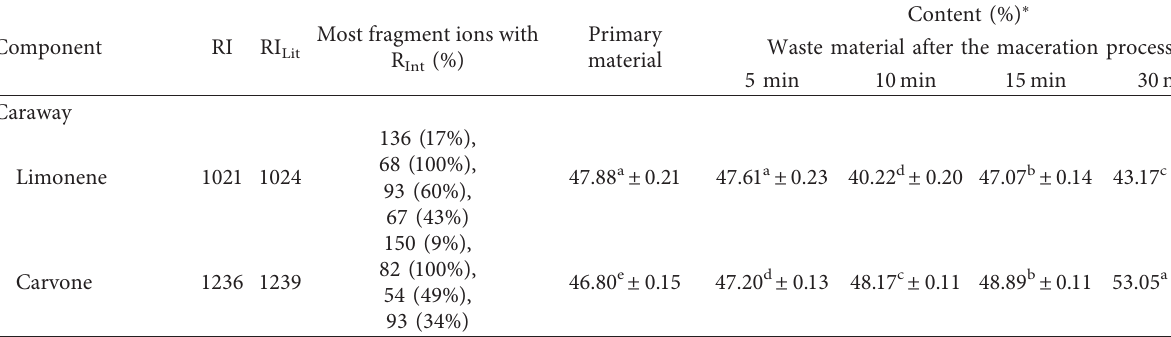
Figure Is: GC-MS chromatogram with dominant compo- nents of sage essential oil. Figure IIs: GC-MS chromatogram with dominant components of lavender essential oil. Figure IIIs: GC-MS chromatogram with dominant components of caraway essential oil. Figure IVs: GC-MS chromatogram with dominant components of chamomile essential oil. Figure Vs: GC-MS chromatogram with dominant compo- nents of peppermint essential oil. Figure VIs: GC-MS chromatogram with dominant components of fennel es- sential oil. ( Supplementary Materials